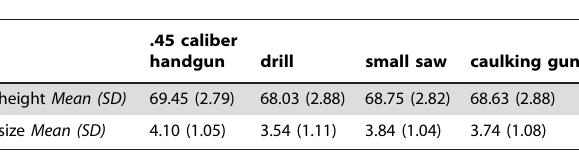
Table 1. Estimated Height and Size (Study